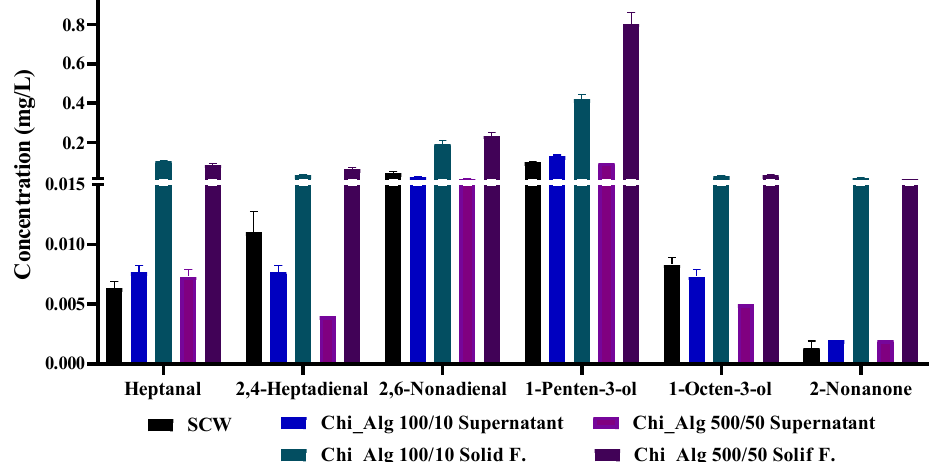
Figure 6. Concentration of the different aromatic markers present in the two fractions obtained by coagulation/flocculation using chitosan/alginate. SCW-sardine cooking wastewaters. To obtain a safe quality ingredient, the effect of an additional sterilisation step on the texture and aroma content of the solid fractions was evaluated (Figure 7). The choice of a thermal method for sterilising this solid fraction was based on the fact that temperature helps to promote the gelatinisation of the coagulant/flocculant present, improving the final texture of the ingredient. Besides this, it allows for a safe product since a thermal treatment will contribute to reducing the microbial load.